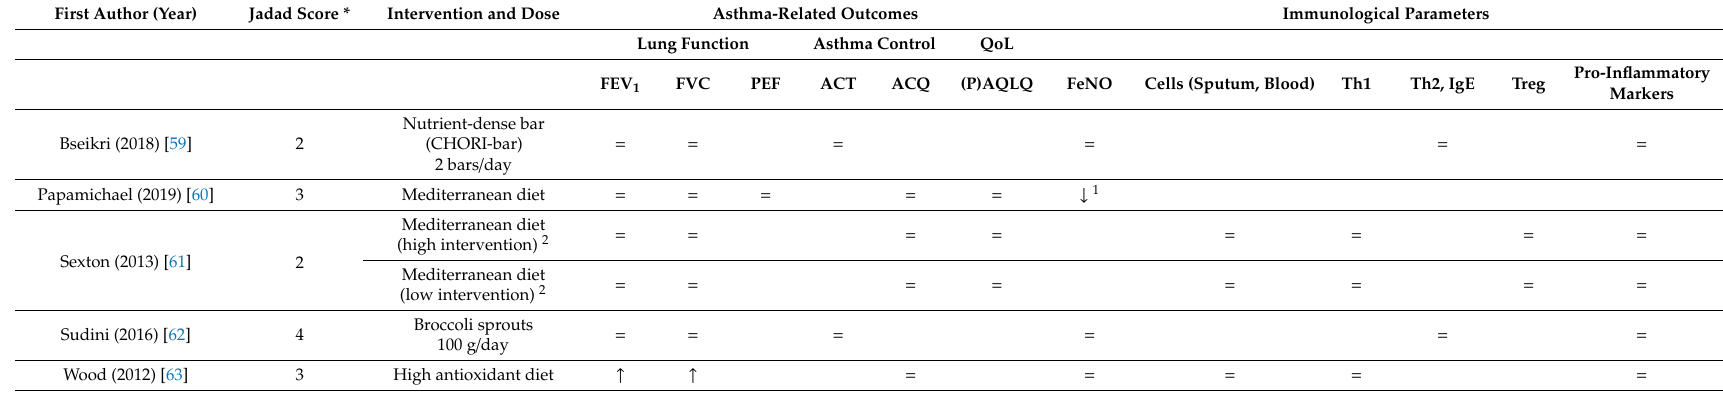
Table 7. Changes in asthma-related outcomes and immunological parameters as compared to the control group for the whole-food approach